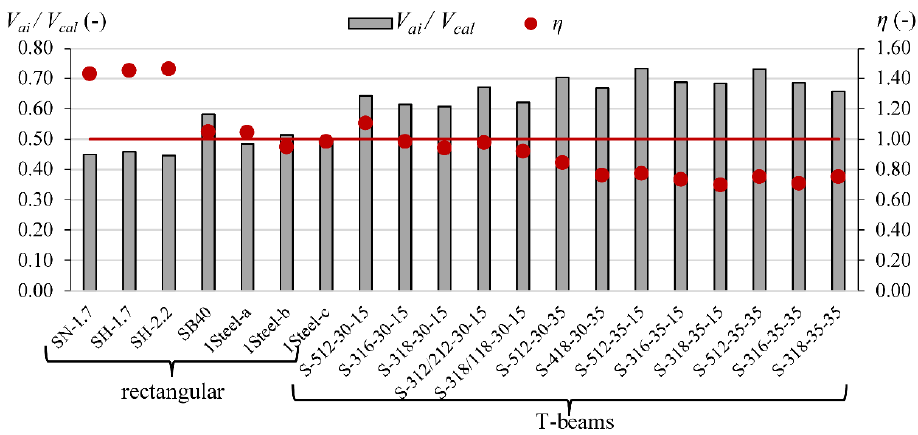
Figure 3. The contribution of the aggregate interlock effect V ai in V cal according to Yang’s model in steel RC beams (red line indicated η = 1).